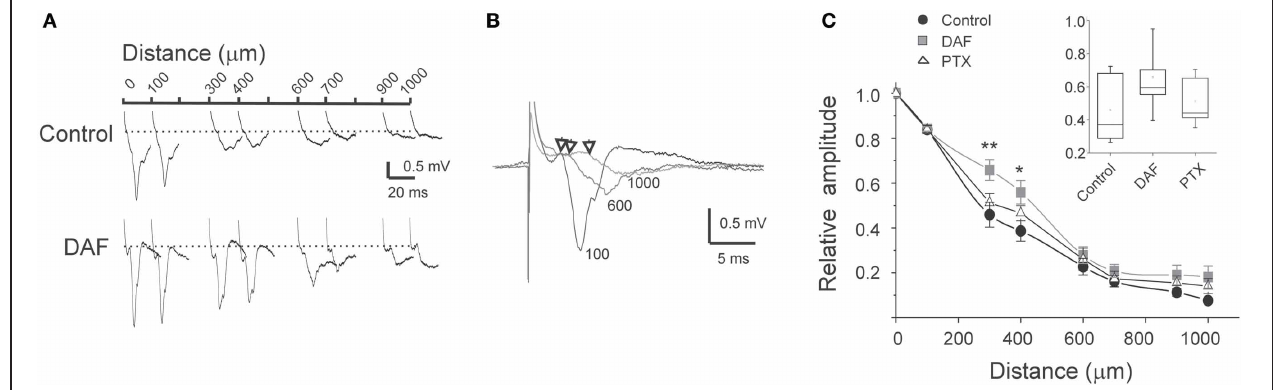
around 3ms for a distance of 1000 μ m. (C) A summary diagram of the LFPs amplitude with distance, normalized to the amplitude above the stimulating electrode (distance 0), for control slices ( n = 16), DAF-treated slices ( n = 13), and PTX-treated slices ( n = 10). Note a significant difference between control and DAF-treated slices at the distances of 300 μ m ( p = 0 . 008), and 400 μ m ( p = 0 . 02). The inset displayed the data distribution for the 300 μ m